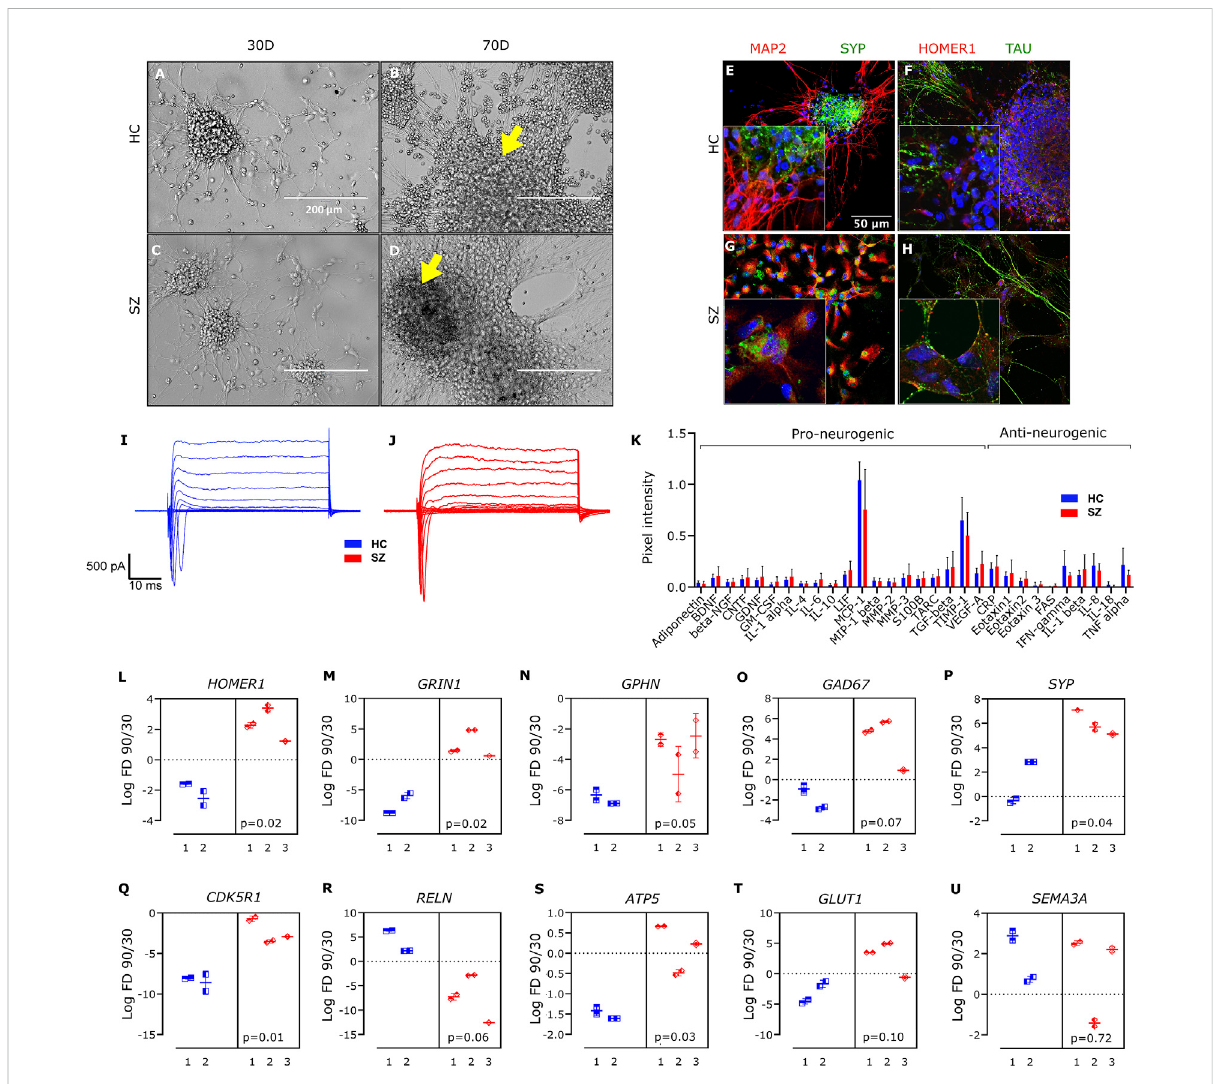
FIGURE 1 Pro fi ling of hiPSCs-derived neurons obtained from HC and SZ patients. (A – D) Representative images for HC- (A,B) and SZ- (C,D) derived neuronalcultures,capturedwithphase-contrastmicroscopyat30 (A,C) and90 (B,D) daysofdifferentiation.Arrowsindicate3Dneuronalaggregates where spontaneous activity was recorded. Calibration bar: 200 µm. (E – H) Representative immune staining for the dendritic and axonal markers MAP2 (E,G) and TAU (F,H) , respectively, as well as for the pan-presynaptic and glutamatergic-postsynaptic proteins synaptophysin (SYP) (E,G) and HOMER1 (F,H) , respectively. DAPI staining is shown in blue. Calibration bar: 36 µm. (I,J) Representative voltage-clamp electrophysiological recordingsat60daysofdifferentiation,forHCandSZ-derivedneurons. (K) Quanti fi cationofneurogenicproteinslevel(mean±SD)intheCMoffour SZ (#1 – 4) and three HC (#1 – 3) cell lines at 75 days of differentiation. (L – U) Fold-change in mRNA expression levels of different genes related to